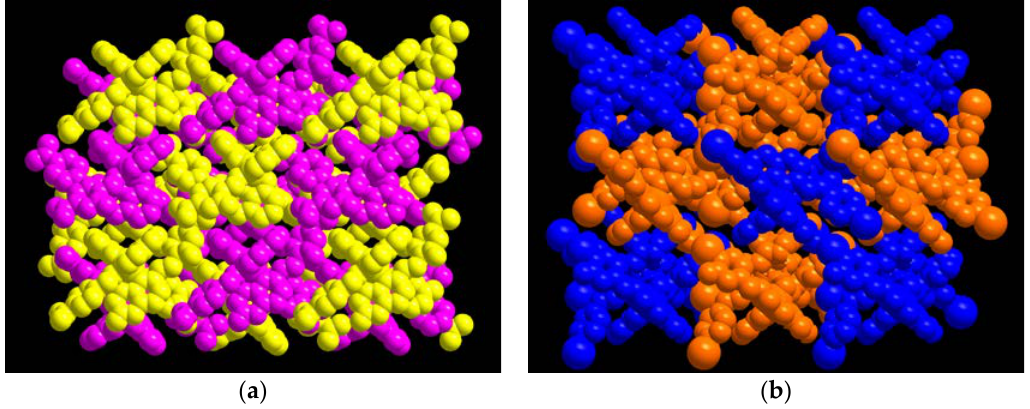
Figure 4. Views of the space-filling representations of the three-dimensional supramolecular structures of 1 ( a ) and 2 ( b